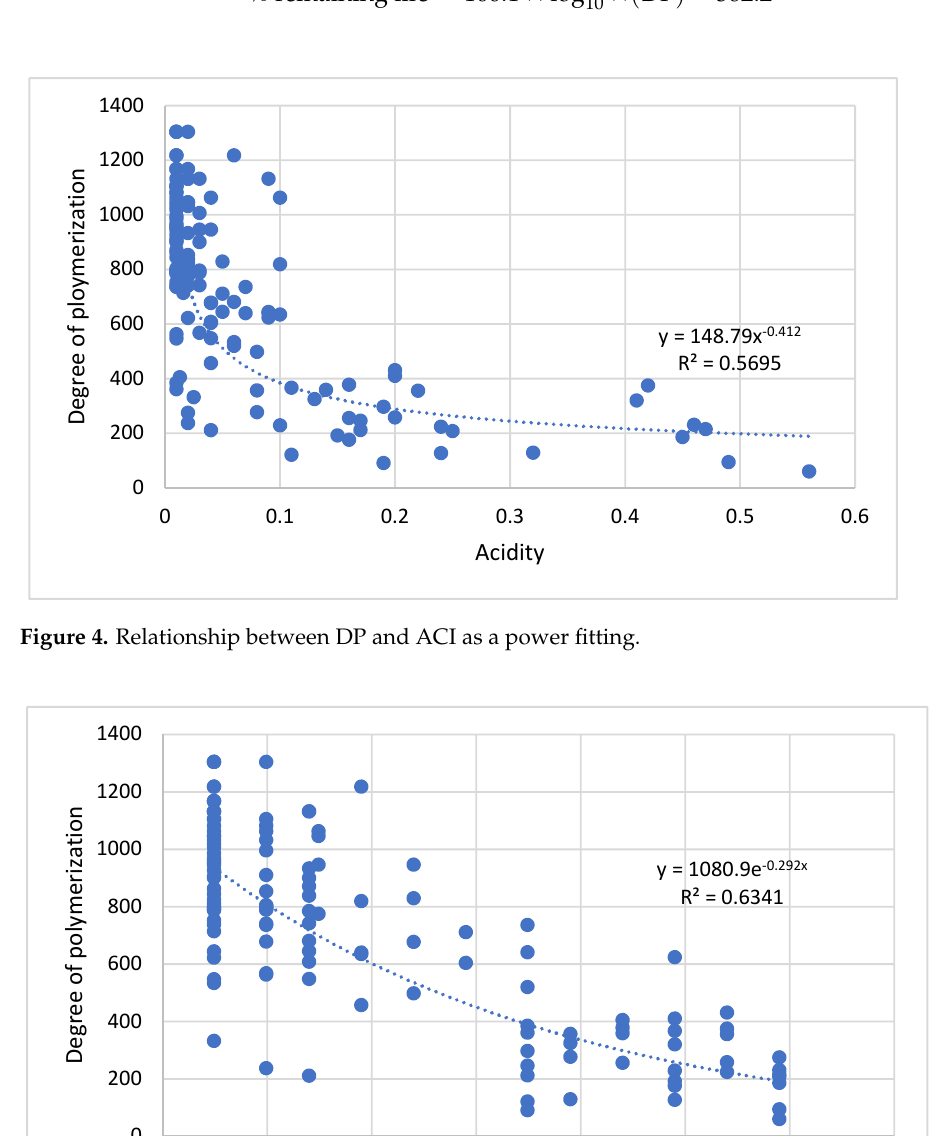
Figure 4. Relationship between DP and ACI as a power fitting.